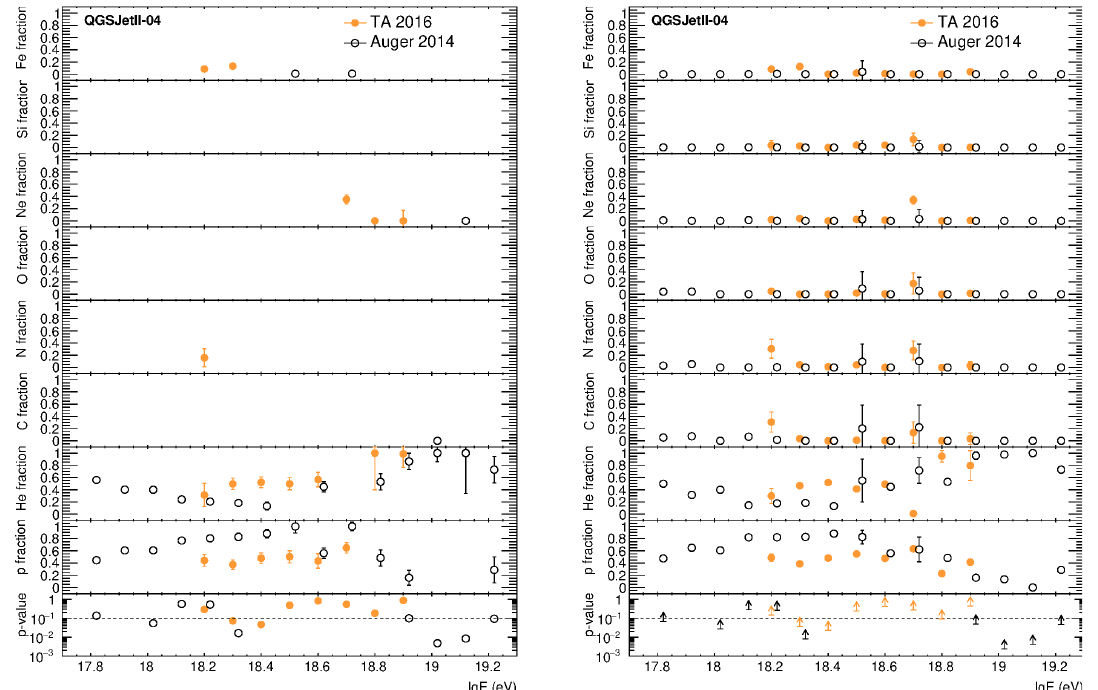
Figure 3. Fitted fractions of individual nuclei in each energy interval obtained with method #1 ( left ) and method #2 ( right ) employing the QGSJETII-04 hadronic interaction model. Full orange circles stand for TA (2016) data while the black open circles represent the Auger (2014) data. The p-value parameters are displayed on the bottom panels as one single value per energy interval ( left ) and a range of p-values represented with arrows ( right ) (see text).